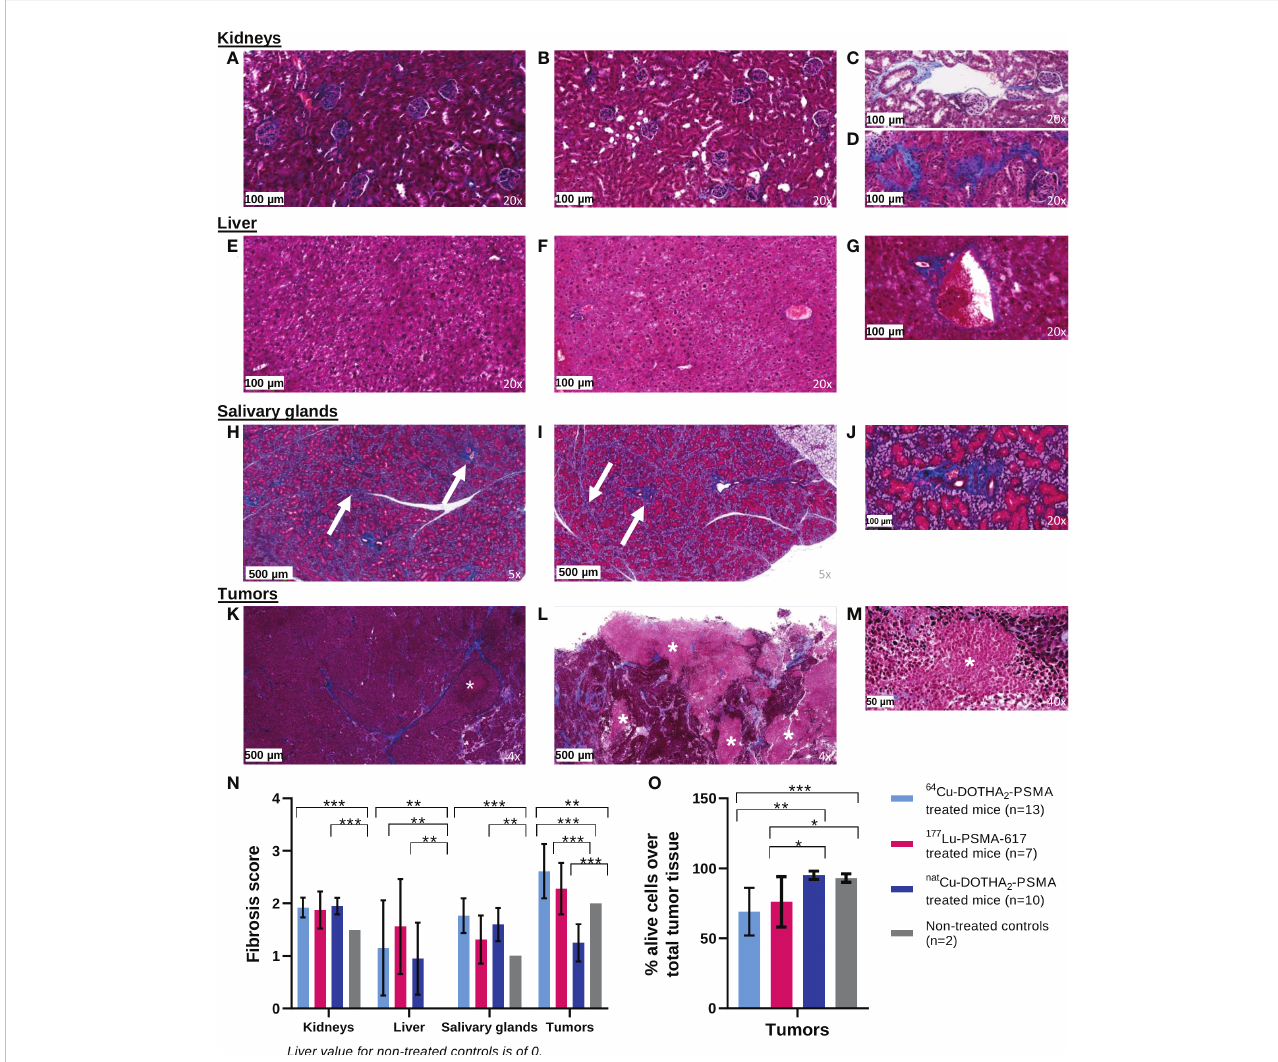
FIGURE 4 Pathology analysis results from controls, non-treated mice (left colum) in comparison to 64 Cu-DOTHA 2 -PSMA treated mice (middle and right columns): Normal kidney histology was mainly found in controls (A) and treated mice (B) , with frequent non-pathological perivascular fi brosis (C) and rare, locally limited interstitial fi brosis (D) . Liver analysis also showed normal, non-injured tissue in controls (E) and treated mice (F) with some periportal fi brosis (G) . All salivary glands displayed non-pathological, expected fi brosis surrounding vessels and excretory duct and in septa in controls (H) and treated mice (I, J) . For LNCaP tumors, controls mainly showed alive tumor bulk, with fi brosis and infrequent necrosis (K) . In opposite, the irradiated tumors showed a lower proportion of alive cells and more necrosis (L, M) . Fibrosis scores by organs are presented in N and the proportion of alive tumor cells over total tumor tissue is presented in O. Stained by Masson ’ s trichome. Fibrosis: blue staining, arrow when needed. Necrosis in the tumor: lighter pink, asterix. In graphs, only signi fi catively different relations are shown. *p < 0.05. **p< 0.01. ***p <